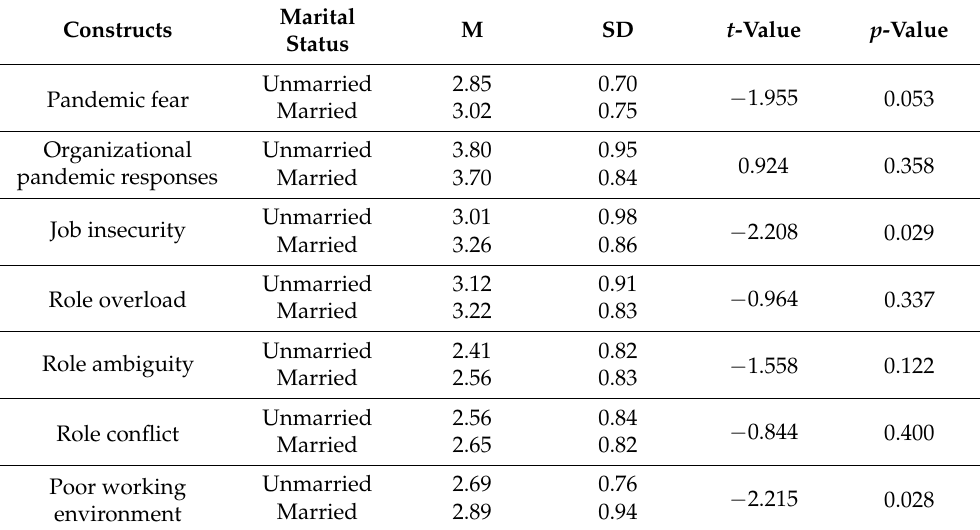
Table 7. Independent sample t -test of the marriage differences for perceived stressors.